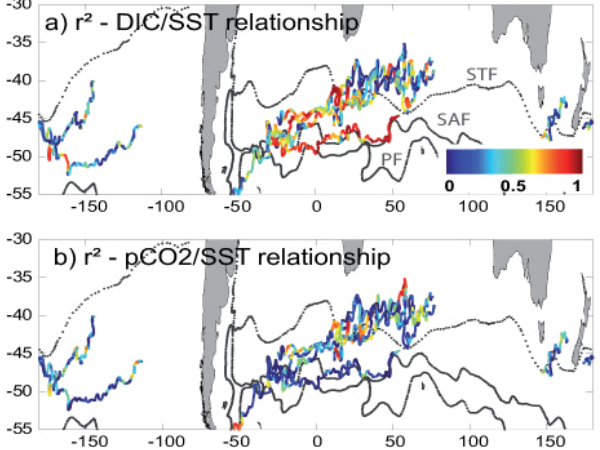
Fig. 8. Correlation coefficient ( r 2 ) for the linear correlation between (a) SST and DIC; (b) SST and p CO 2 . Fronts are indicated in